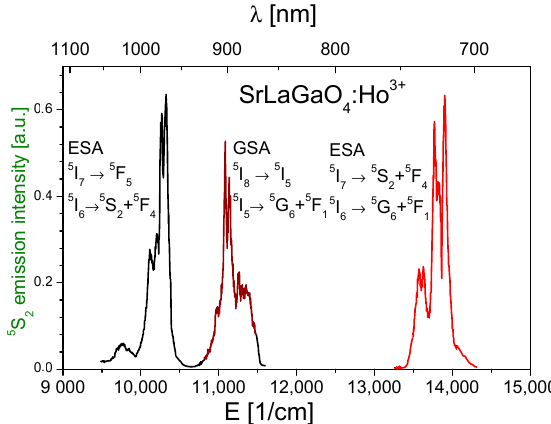
Figure 8. Energy level diagram of Ho 3+ presenting different paths of populating the 5 S 2 state of Ho 3+ involving GSA and ESA processes.